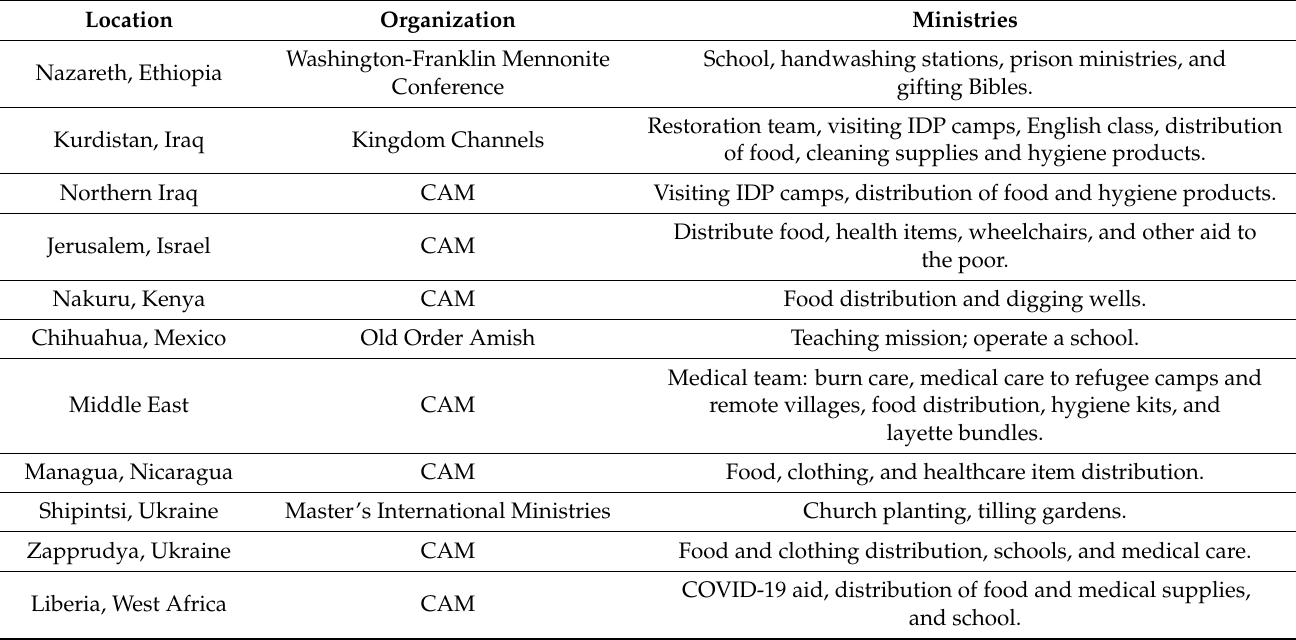
Table 1. Missionary Locations, Organizations, and